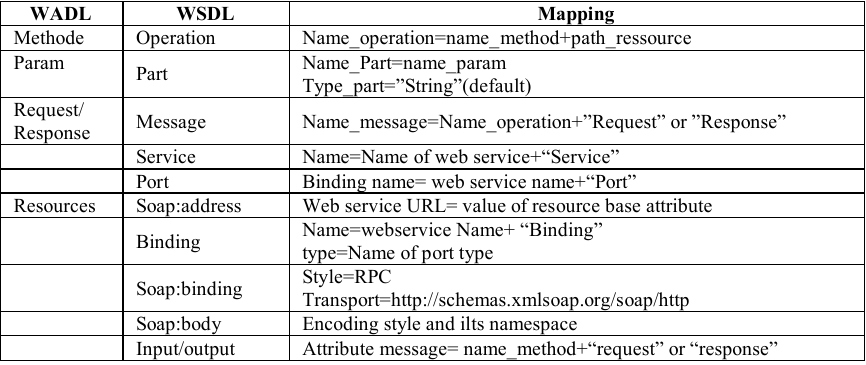
Table 1. Mapping rules WADL object to WSDL